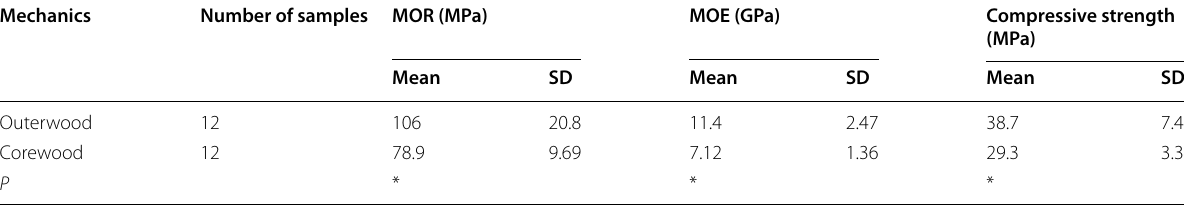
* P < 0.05 showed a significant